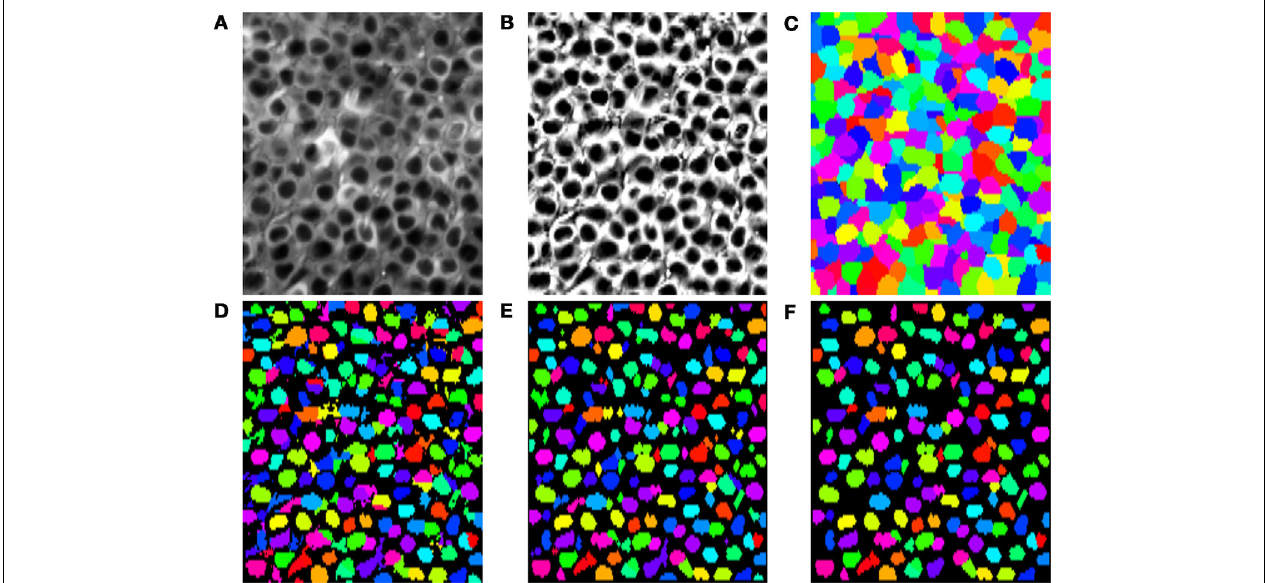
FIGURE 5 | Segmentation steps or identifying pyramidal cell nuclei with the ’ca1pc’ variant of the normalized cuts segmentation approach. (A) The time-averaged image of the time-series to be segmented. (B) Application of CLAHE and unsharp mask image processing to (A) . (C) Disjoint regions identified by iterative partitioning